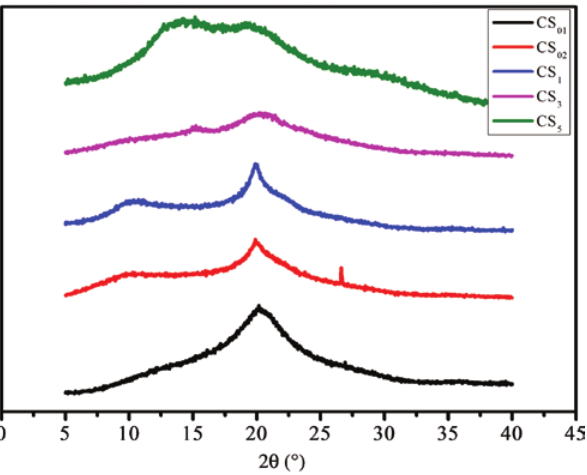
= 15.85 kDa), CS (M 1 w = 5.17 kDa), CS (M 4 w